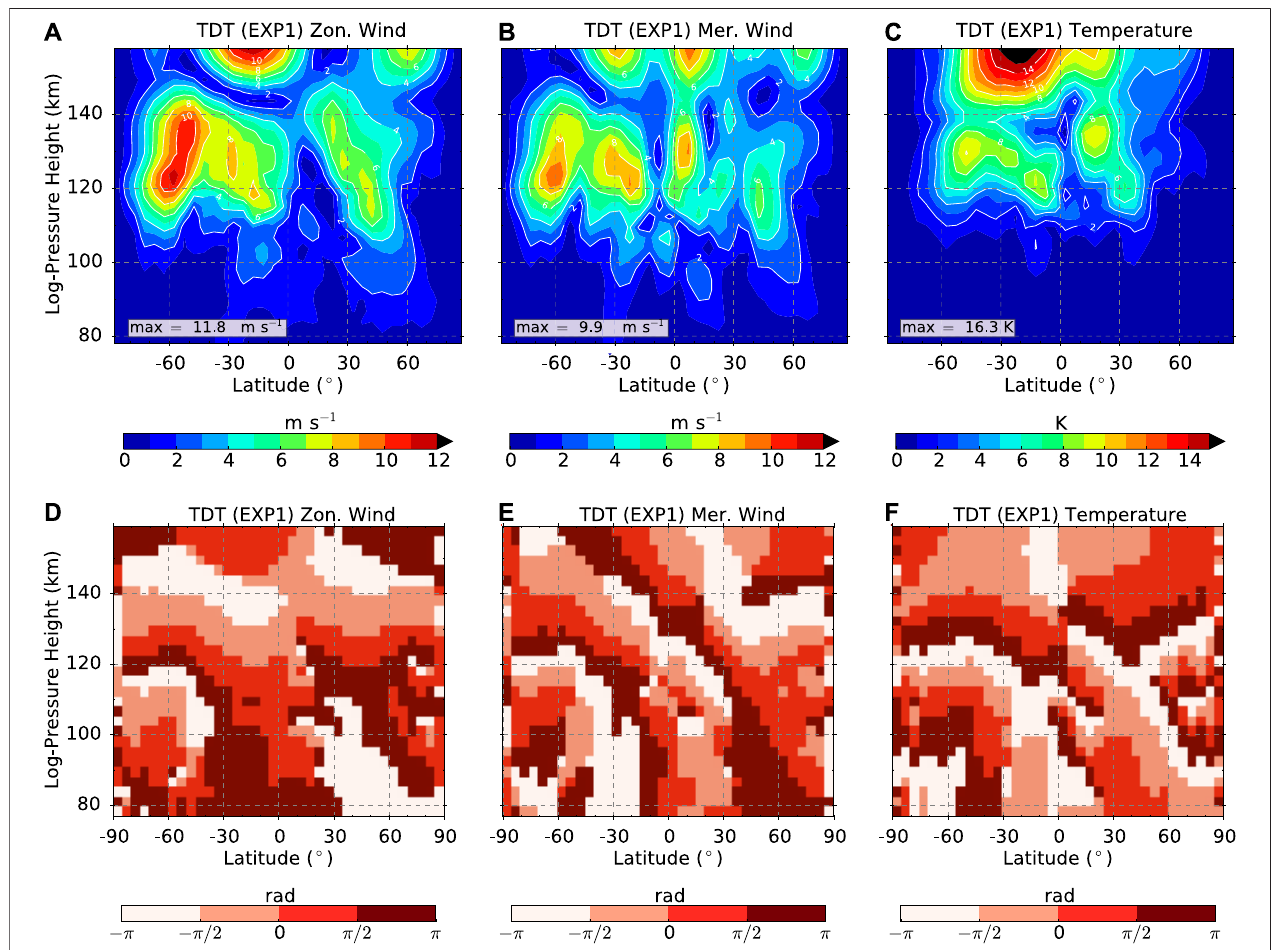
FIGURE 8 | Zonal mean TDT amplitudes of (A) zonal wind (in m s − 1 ), (B) meridional wind (in m s − 1 ) and (C) temperature (in K) for EXP1. (D – F) Corresponding TDT phases (in radians).